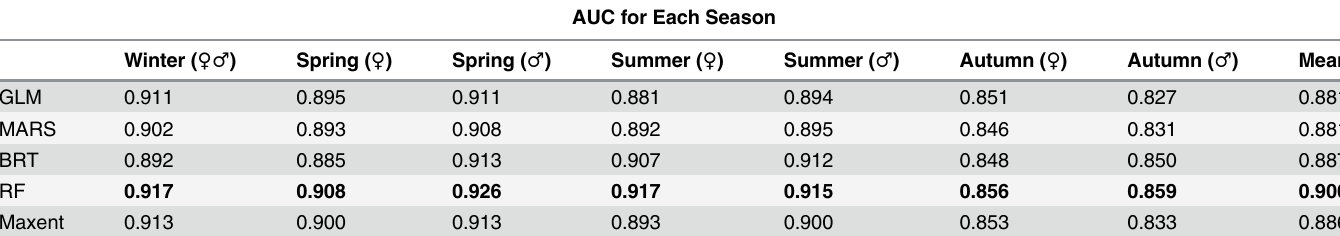
Table 2. Comparison of Area Under the Curve (AUC) statistic using test data and the cross-validation mean for each season and each of 5 species distribution model forms using the final set of predictor variables in modeling patterns of seasonal distribution of hoary bats ( Lasiurus cinereus ) in North America.